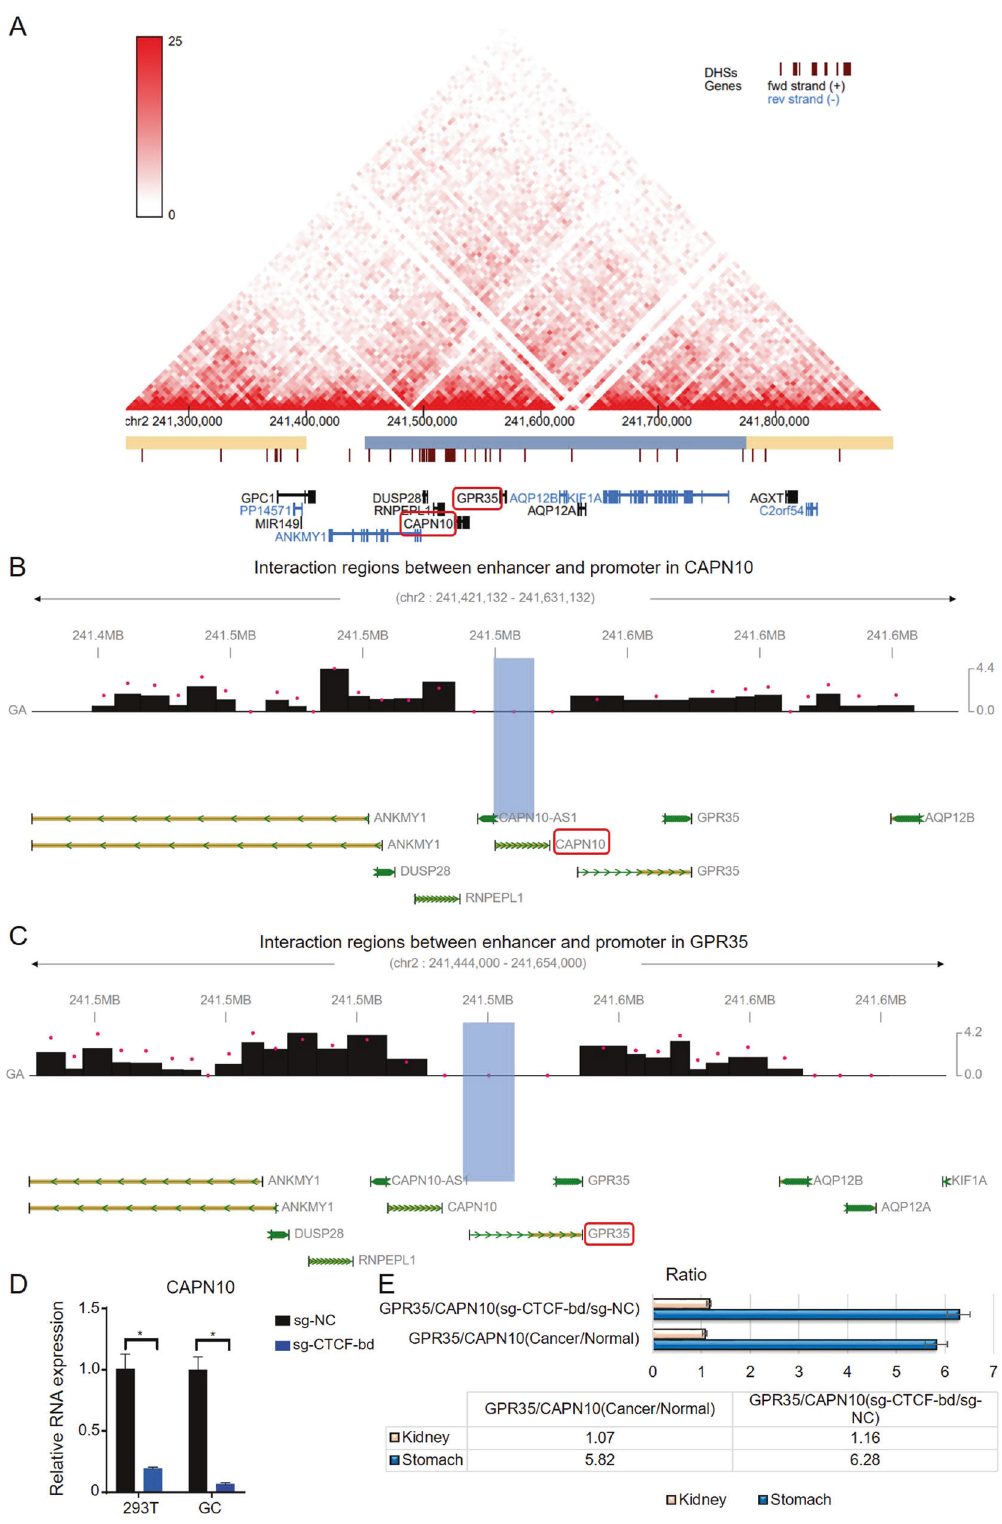
Fig. 2 ERR event for orphan GPR35 in GC tumors. A GPR35 and CAPN10 were located in the same TAD. B Interaction between the enhancer and promoter of CAPN10. C Interaction between the enhancer and promoter of GPR35. D Knocked out CTCF-bd (CTCF-binding domain) in fl uences CAPN10 expression level. E Compare kidney cancer, ERR-activated GPR35 expression in gastric cancer and cell.